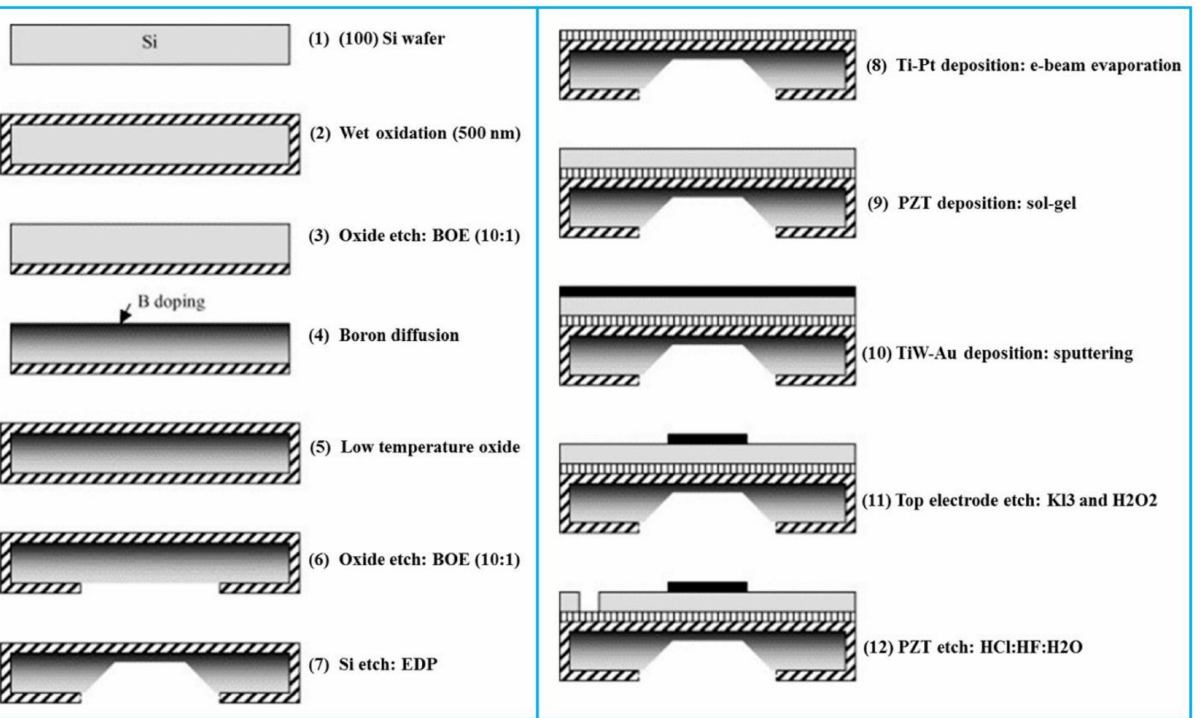
Figure 4. A typical fabrication processes of PMUT by the backside etching method. Reprinted from Ref. [20] with